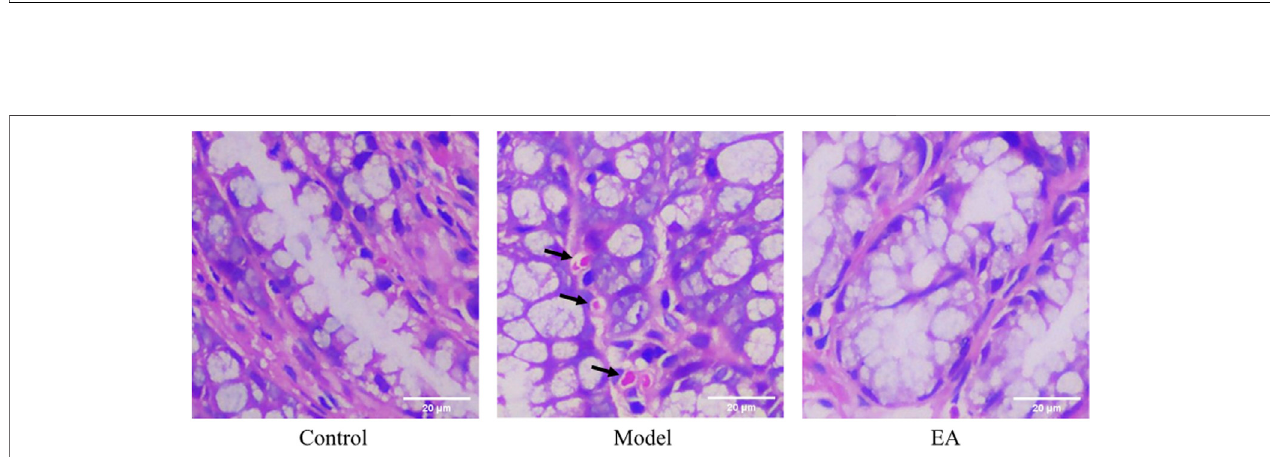
FIGURE2| EAeffectonIBS-Dsymptoms.Visceralhypersensitivity,anxiety-likebehaviors,andtheseverityofdiarrheaweremeasuredusingAWRscores (A) ,OT% (B) ,andDI (C) .one-wayANOVAindicatedthatallindexesweresigni fi cantlyhigherinthemodelgroup( p < 0.01)andlowerintheEAgroup.Bar:mean±SE; n =10;** p < 0.01, versus the control group; △△ p < 0.01, versus the model group.